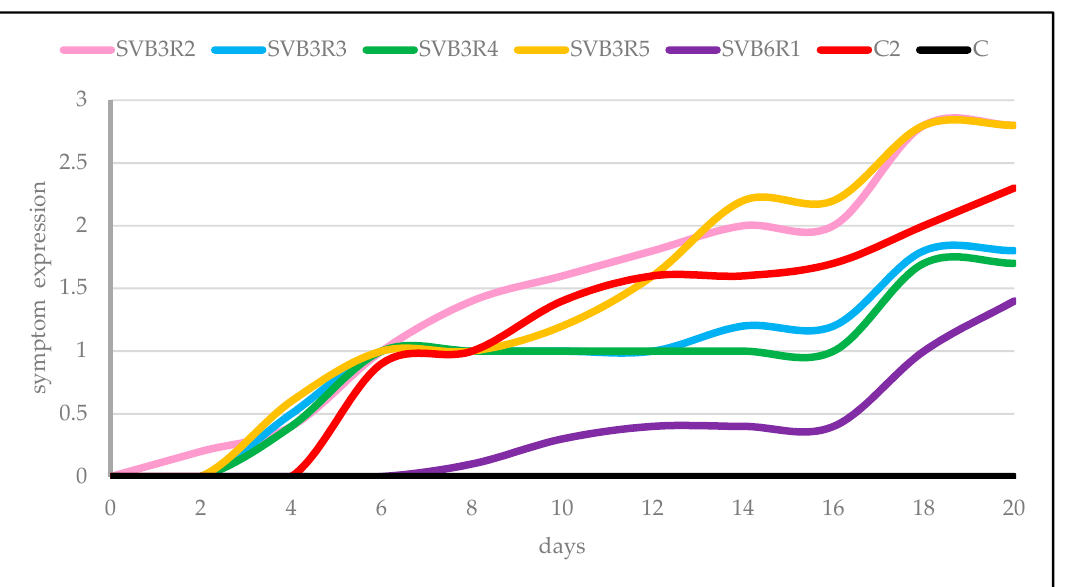
Figure 6. Symptom expression (mean values, n = 7) in inoculated and uninoculated plants exposed to 150 mM salt: 0 = absence of evident symptoms, 1 = weak symptoms (yellowing of the leaf tips), 2 = strong symptoms (leaves dried or completely yellow), and 3 = plant death. Bacterial treatments: P. migulae SVB3R2 (SVB3R2), P. migulae SVB3R3 (SVB3R3), P. migulae SVB3R4 (SVB3R4), Pseudomonas sp. SVB3R5 (SVB3R5) and P. brassicacearum SVB6R1 (SVB6R1).